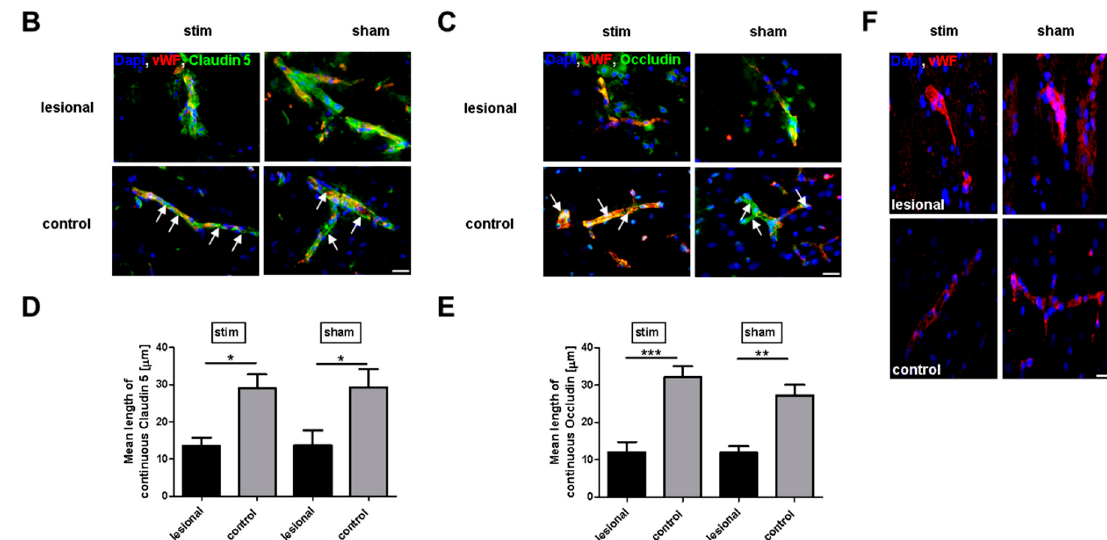
Figure 3. Stimulation of the mesencephalic locomotor region does not modulate photothrombosis-driven tight junction morphology and endothelial activation. ( A) Representative immunocytologic staining of von Willebrand factor (vWF) in the ischemic hemisphere 27 h after photothrombosis within the two treatment groups. The dashed line indicates the border to the photothrombotic stroke (lesional) (Scale bar: 200 µm). ( B–E) Representative images of anti-claudin 5 and anti-occludin immunohistochemistry in the ipsilatateral (lesional or control) area and quantification of the mean length of the tight junction morphology 27 h after photothrombosis of unstimulated (sham) and high-frequency stimulated (stim) rats ( n = 5 – 7/group). One-way ANOVA.* p < 0.05; ** p < 0.01; *** p < 0.001. (Scale bar: 25 µm). ( F ) Representative anti-vWF staining in the ipsilesional hemisphere 27 h after photothrombosis within the two treatment groups (Scale bar: 25 µm).